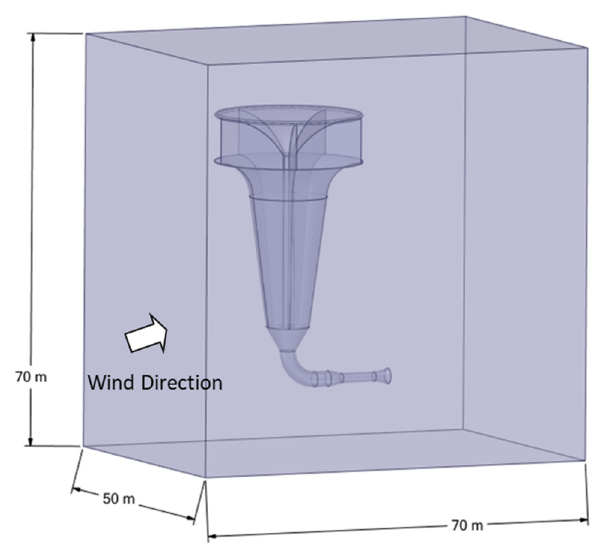
Figure 2. Dimensions of computational domain.